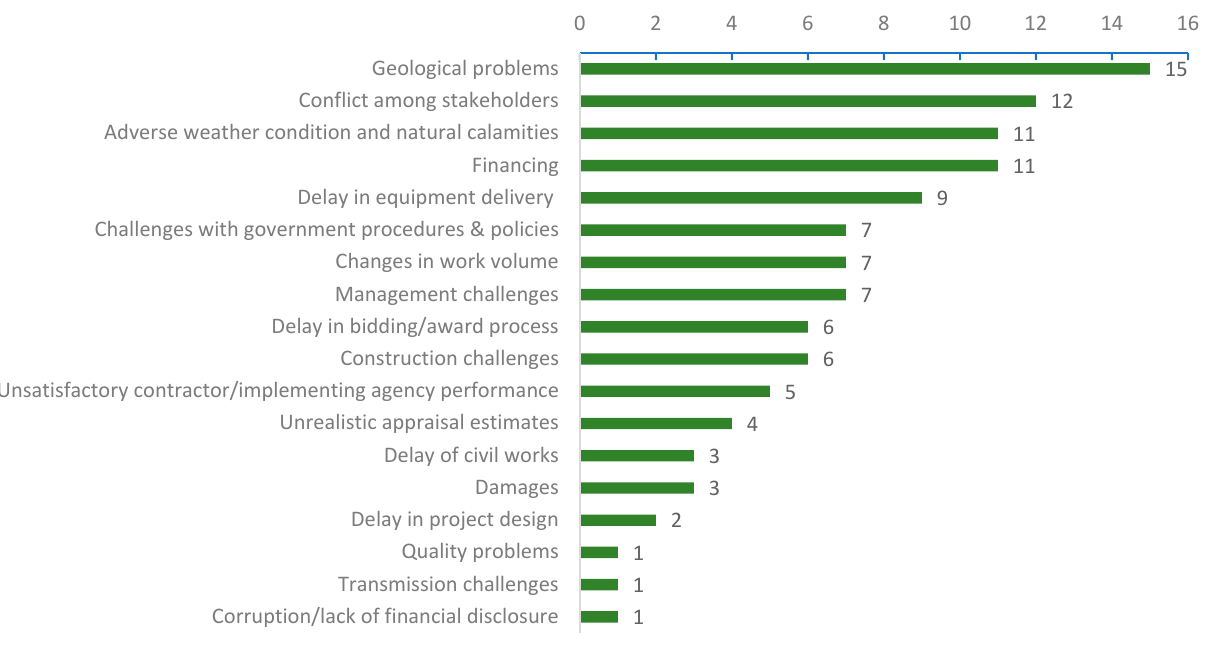
Figure 2. Causes of time overruns (summary).